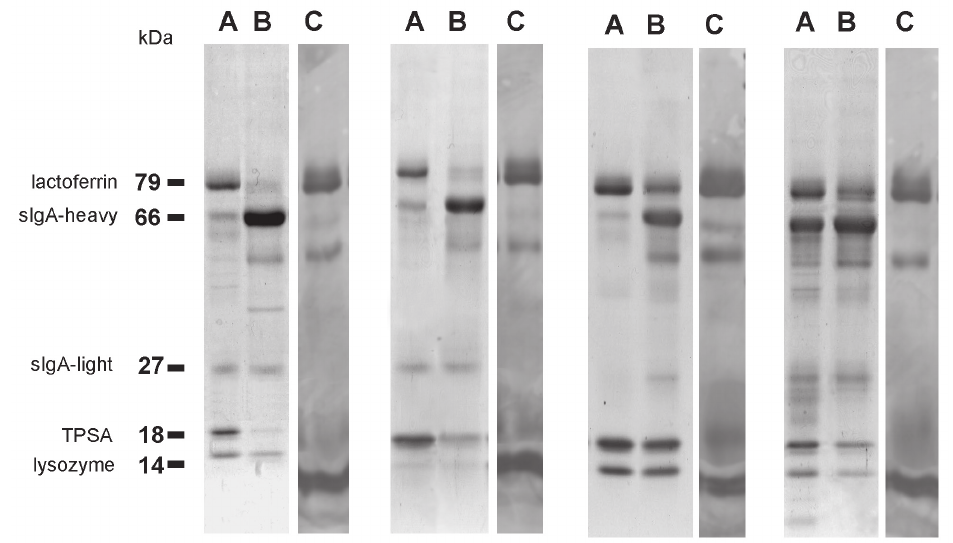
Figure 2 - Protein profile in tear of allergic and adenoviral conjunctivitis. Electrophoretic profiles of human tear fluid on SDS-PAGE revealed by Coomassie blue staining. In A (contralateral eye), B (acute adenoviral conjunctivitis eye) and C (allergic conjunctivitis), the corresponding profiles of 4 different subjects are shown. Protein bands were identified by matching their migrations to those of molecular weight standards; lactoferrin (79 kDa), serum albumin and sIgA-heavy chain (66 kDa), sIgA-light chain (27 kDa), lipocalin (TPSA, 18 kDa), and lysozyme (14